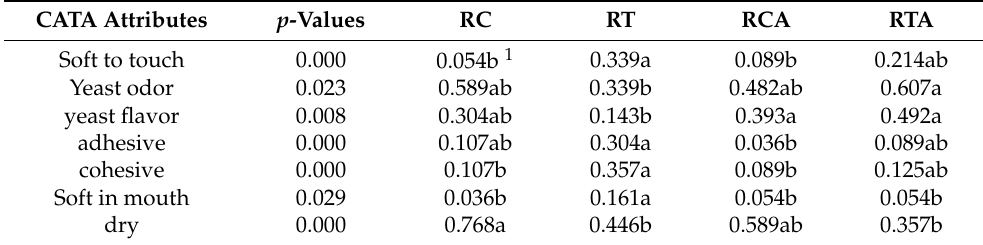
Table 7. Attributes significantly different in Cochran’s Q test analysis ( p < 0.05).